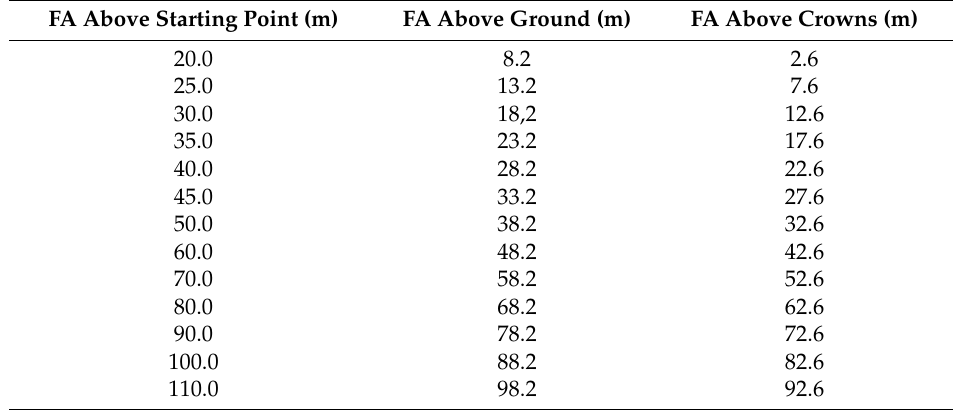
Table 1. Vertical Analysis: Flying altitude (FA) of hexacopter above starting point, ground, and crowns.